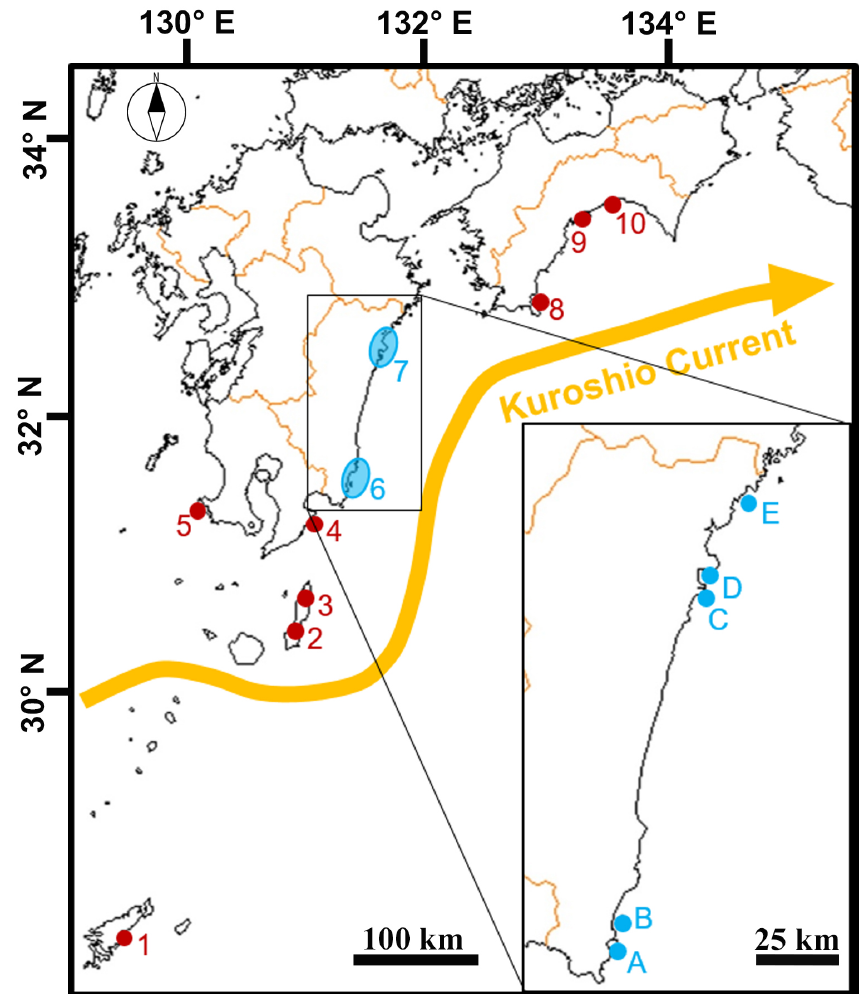
Figure 1. Map showing literature records based on vouchers (red numbers) and the sampling points of this study (blue numbers and letters) for tropical species of Leiognathidae along the Kuroshio Current (orange line) in southern Japan. The numbers and letters represent the following sites: 1, Sumiyo Bay, Amami Island; 2, southern part of Tanega-shima island; 3, northern part of Tanega-shima island; 4, Uchinoura Bay, Kagoshima Prefecture; 5, Kasasa Town, Kagoshima Prefecture; 6, southern part of Miyazaki Prefecture; 7, northern part of Miyazaki Pre- fecture; 8, Iburi, Tosa-shimizu City, Kochi Prefecture; 9, Urado Bay, Kochi Prefecture; 10, Konan City, Kochi Prefecture; A, B, collecting points to be landed in the Meitsu Fishing Port; C, collecting point to be landed in the Tomishima Fishing Port ; D, collecting point to be landed in the Kadogawa and Iorigawa fishing ports; E, collecting point to be landed in the Urashiro Fishing